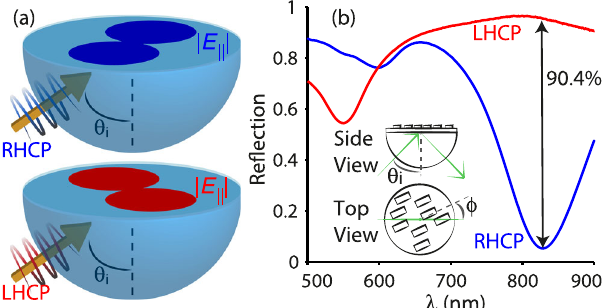
FIG. 1. (a) The in-plane electric field amplitudes E ∥ calculated using Fresnel coefficients of an air-glass boundary at θ i ¼ 45 ° > θ ≈ 42 ° incidence, using RHCP and LHCP illumination. c (b) Reflection measurements from an array of anisotropic gold nanoparticles, under RHCP and LHCP illumination, at θ i ¼ 45 ° and optimal sample orientation ϕ ¼ 25 °. The insets in (b) define the incidence angle θ i and the nanoparticle orientation ϕ